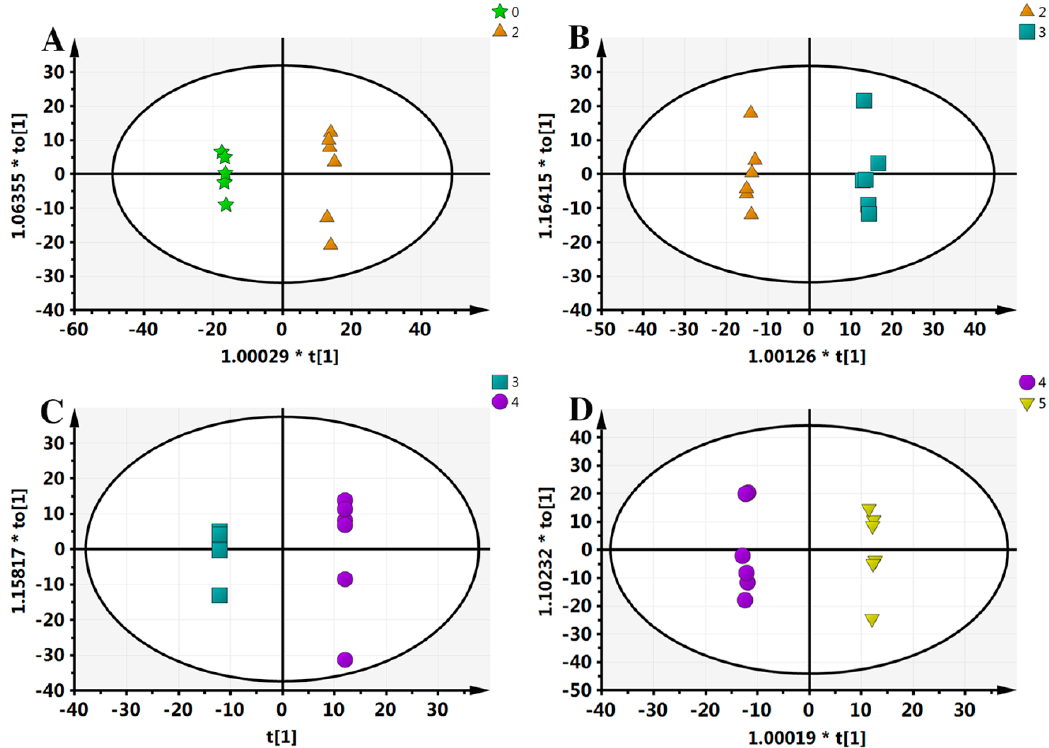
Figure 3. Orthogonal projection to latent structures-discriminant analysis (OPLS-DA) results of all samples. ( A ) 0–2 comparison, scanned by ESI+; ( B ) 2–3 comparison, ESI+; ( C ) 3–4 comparison, ESI+; ( D ) 4–5 comparison, ESI+. “*” means the sample separation significantly.